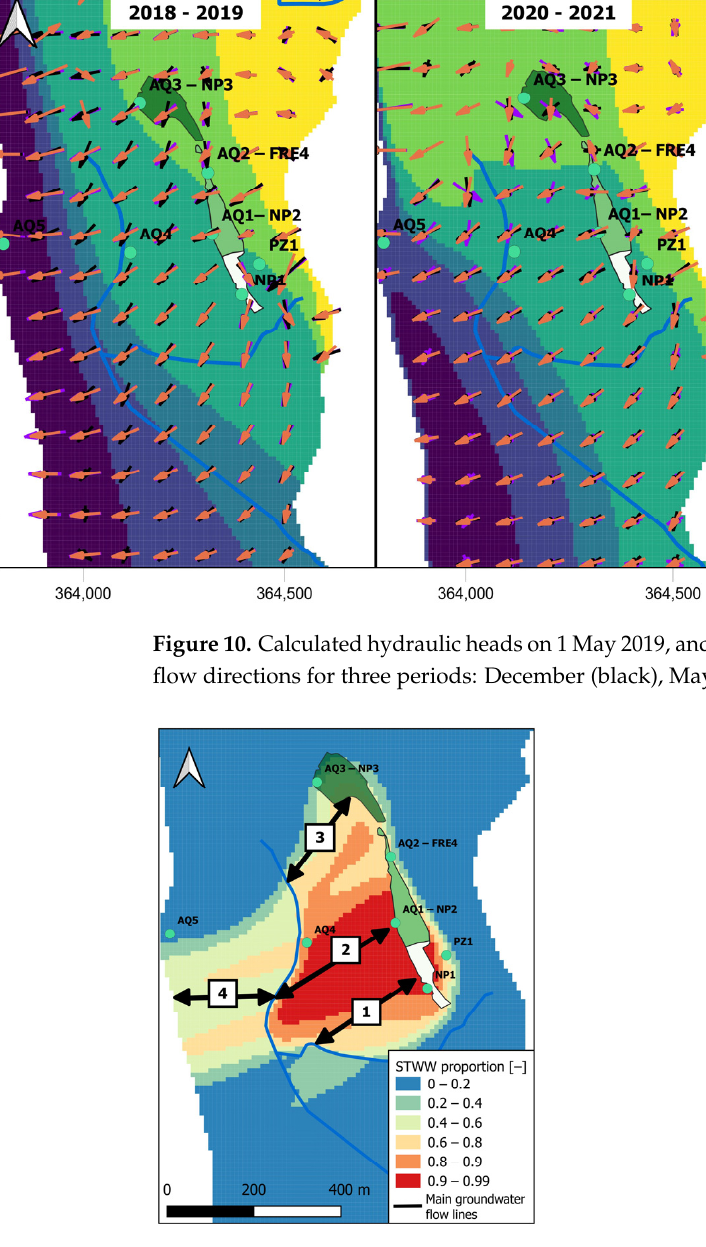
Figure 10. Calculated hydraulic heads on 1 May 2019, and 1 May 2021. The arrows show ground- water flow directions for three periods: December (black), May (purple), and August (orange).